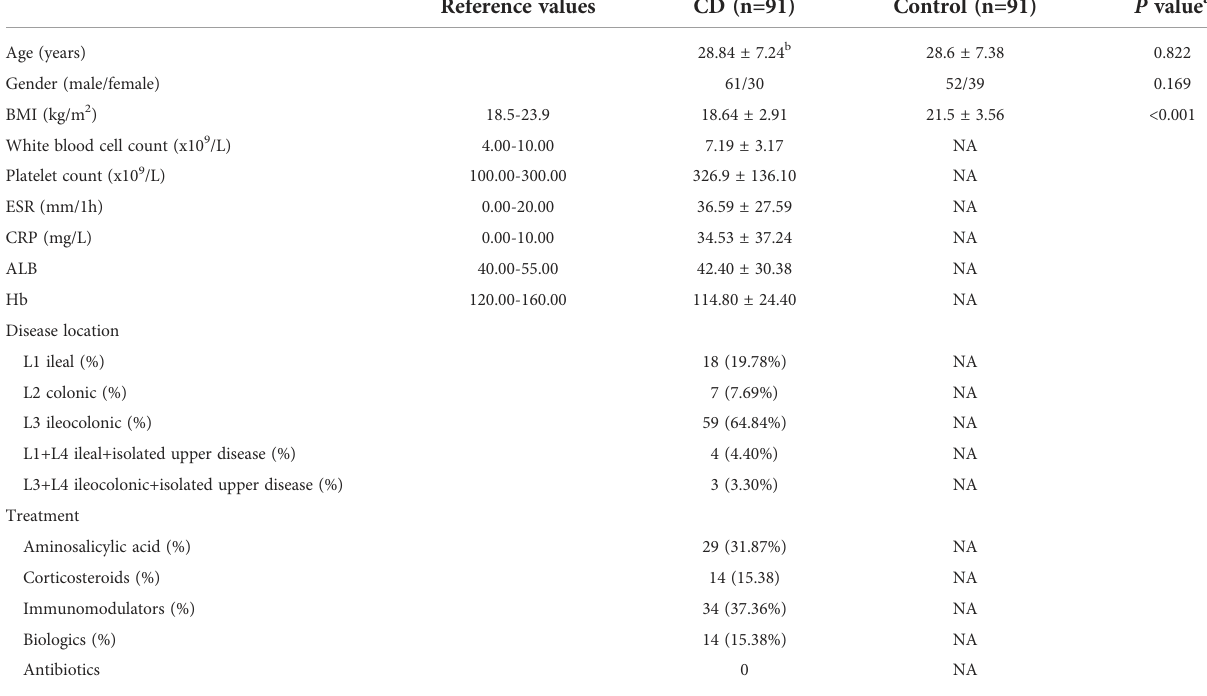
TABLE 1 Characteristics of the